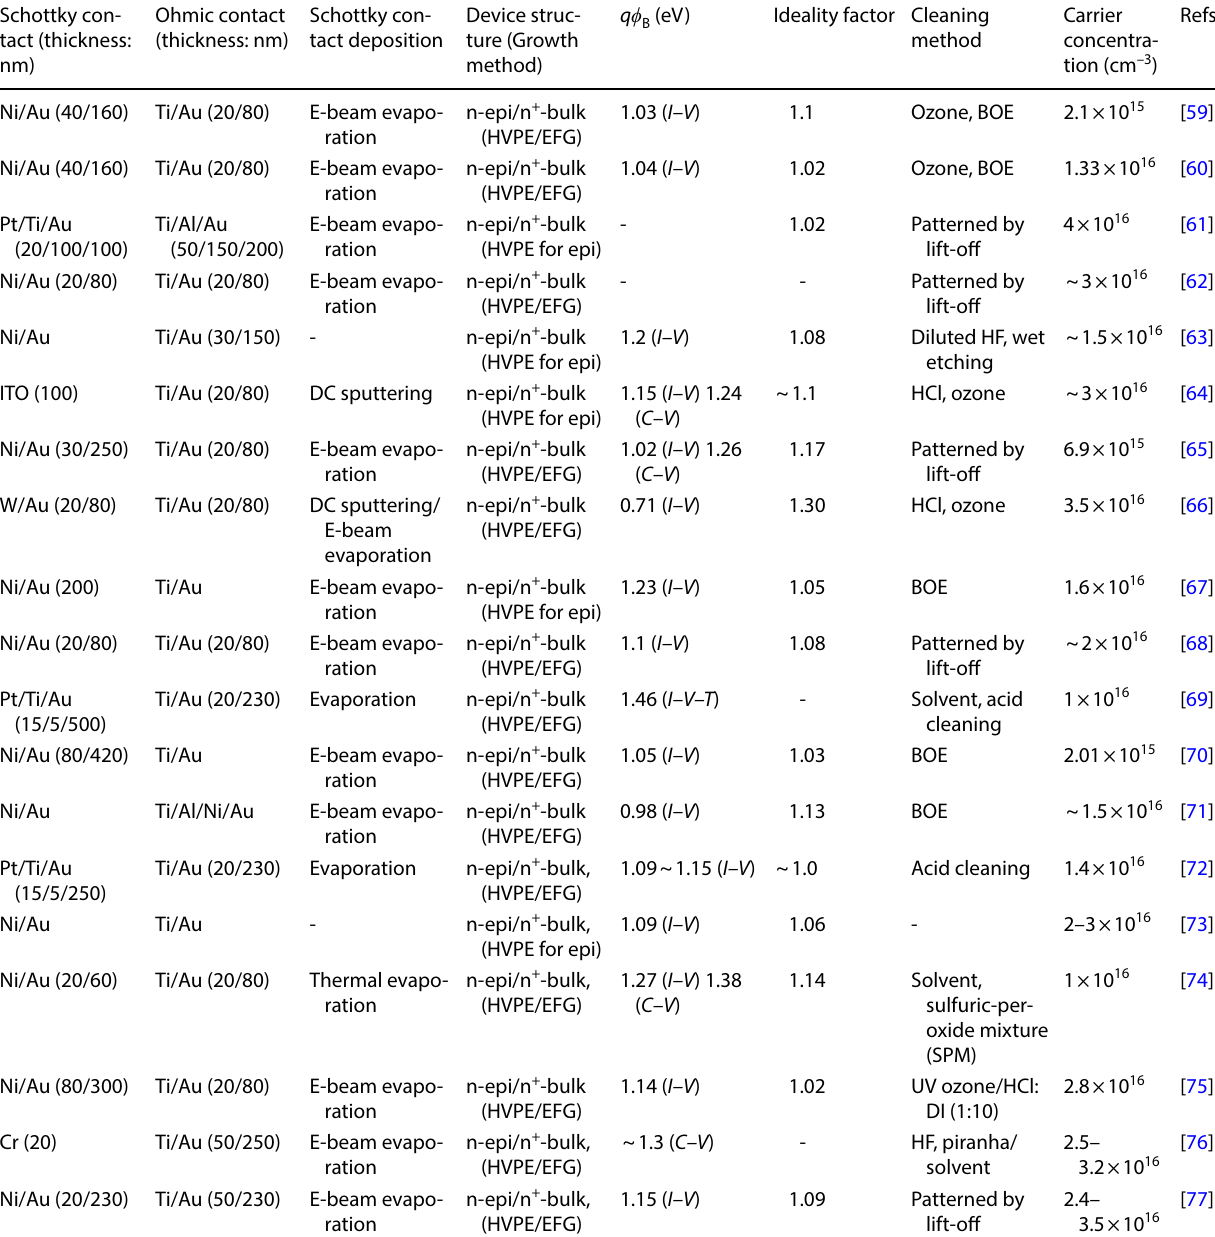
O reported in the 2 3